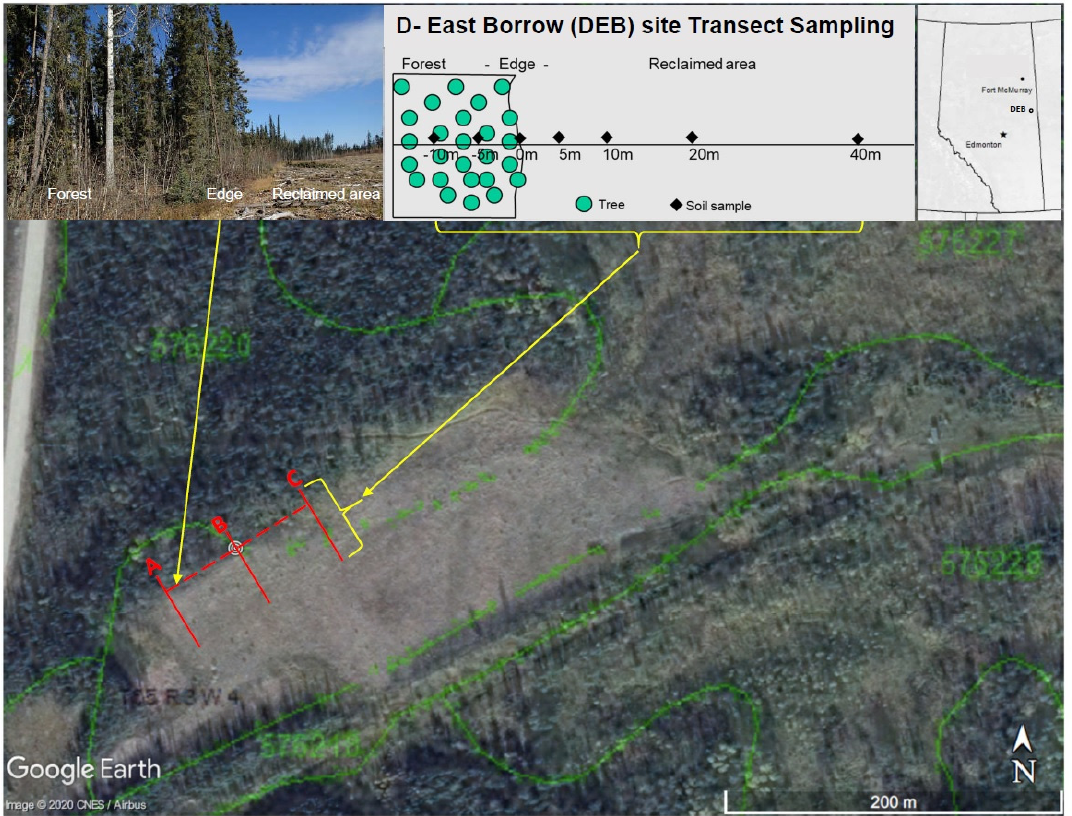
Figure 1. Satellite image in 2015 of the D- East Borrow (DEB) site (concentric circles symbol - UTM zone 12V, easting 538816, northing 6058237) in east central Alberta, Canada after completion of reclamation, with an overlay (green lines and numbers) showing forest cover types mapped in 1999 prior to the start of forest harvest and gravel mining. The three ( A , B , C ) 50 m transects (red lines) sampled in 2016, spanned the edge of the uncut forest and reclamation area, 10 m within the forest and 40 m in the reclaimed area. Soil was sampled at seven locations along each transect. Most of the DEB site had been within mixed white spruce and aspen forest (polygon 576227). However, the NW portion of the site (and part of transect C) had been within black-spruce-dominated forest (polygon 576220). See text for descriptions of the site history and forest types.